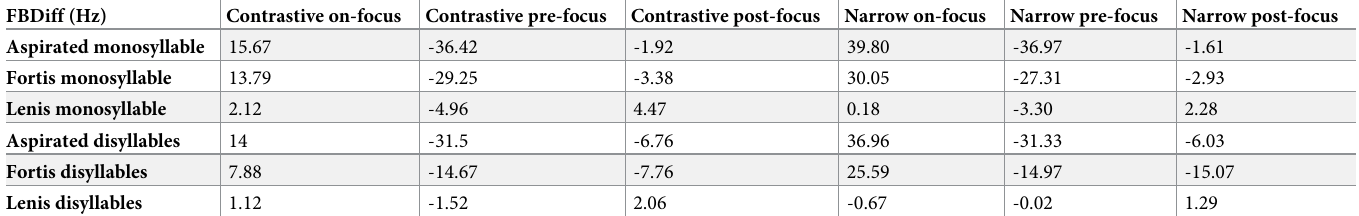
Table 6. Mean f0 perturbation magnitude between baseline and various focus conditions (FBDiff = focus–baseline) of Korean. The positive sign indicates an increase in f0, compared to the baseline and the negative sign indicates a decrease in f0. FBDiff (Hz) Contrastive on-focus Contrastive pre-focus Contrastive post-focus Narrow on-focus Narrow pre-focus Narrow post-focus Aspirated monosyllable 15.67